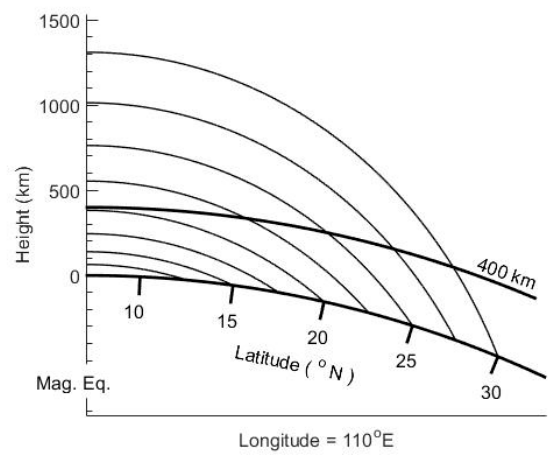
Figure 2. A sketch of magnetic lines from the magnetic equator to low latitudes.